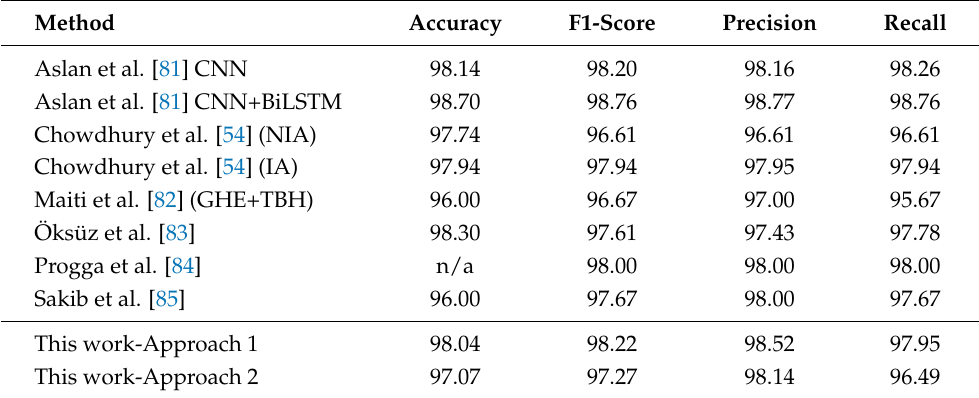
Figure 5. Grad-CAM visualisation for the COVID-19 class using the EfficientNetB4-based Approach 1 model for four chest X-ray images. Table 6. Classification performance (%) of the best configurations versus other works using the same data set for the same task.